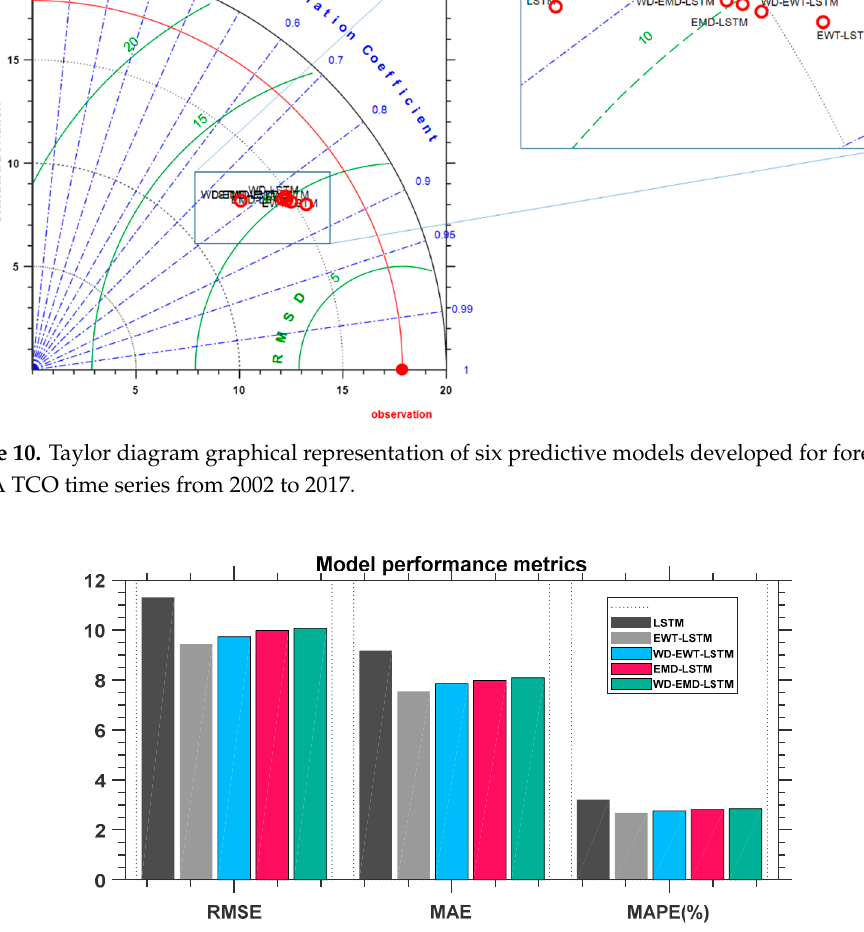
Figure 11. Error graphics of models performance of OCBA TCO time series. RMSE, root mean square error; MAE, mean absolute error; MAPE, mean absolute percentage error.